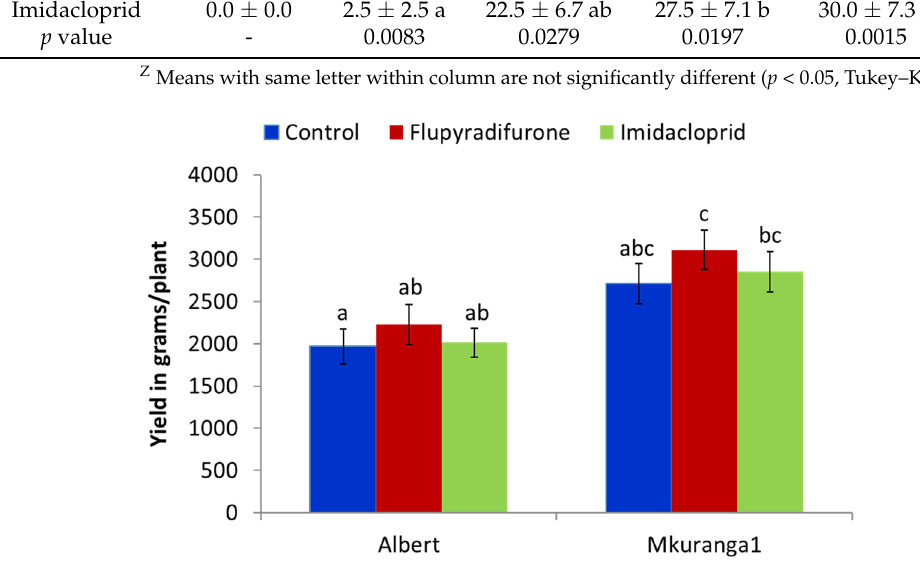
Figure 7. Yield of two cassava varieties (Albert, Mkuranga1) in response to cutting dipping in flupyradifurone and imidacloprid insecticides (Means ± SE). Means with the same letter are not significantly different ( p < 0.05, Tukey–Kramer test) .